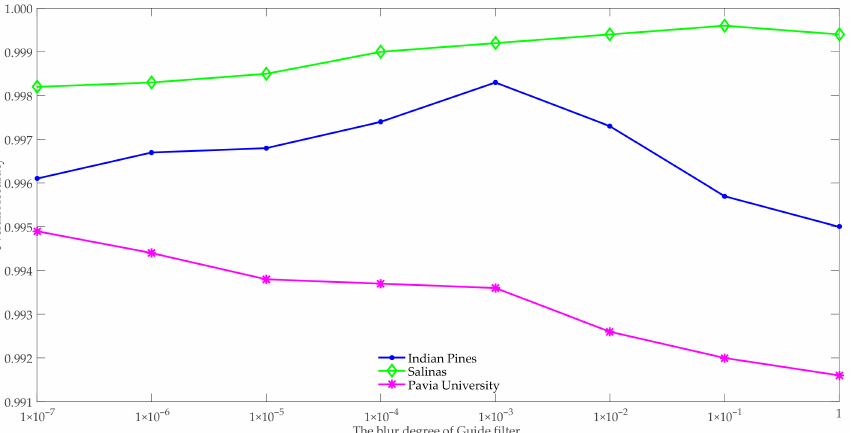
Figure 9. The relationship of OA and ε in the three